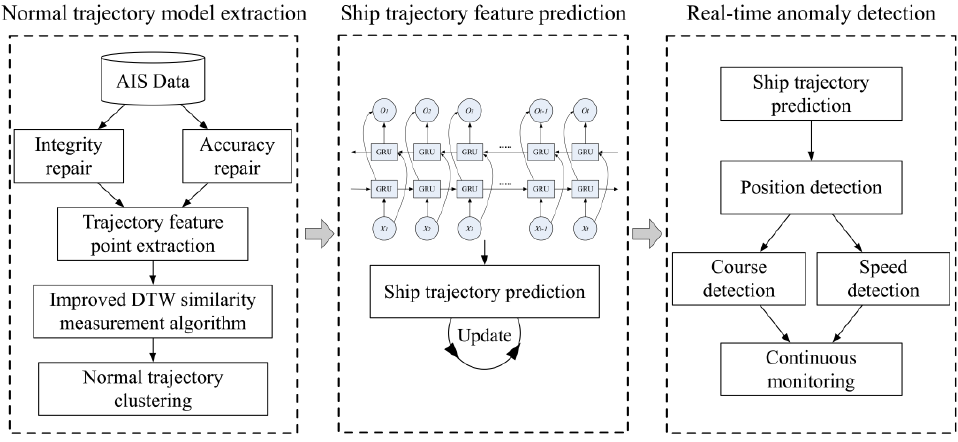
Figure 12. Process of the proposed ship abnormal behavior detection method.